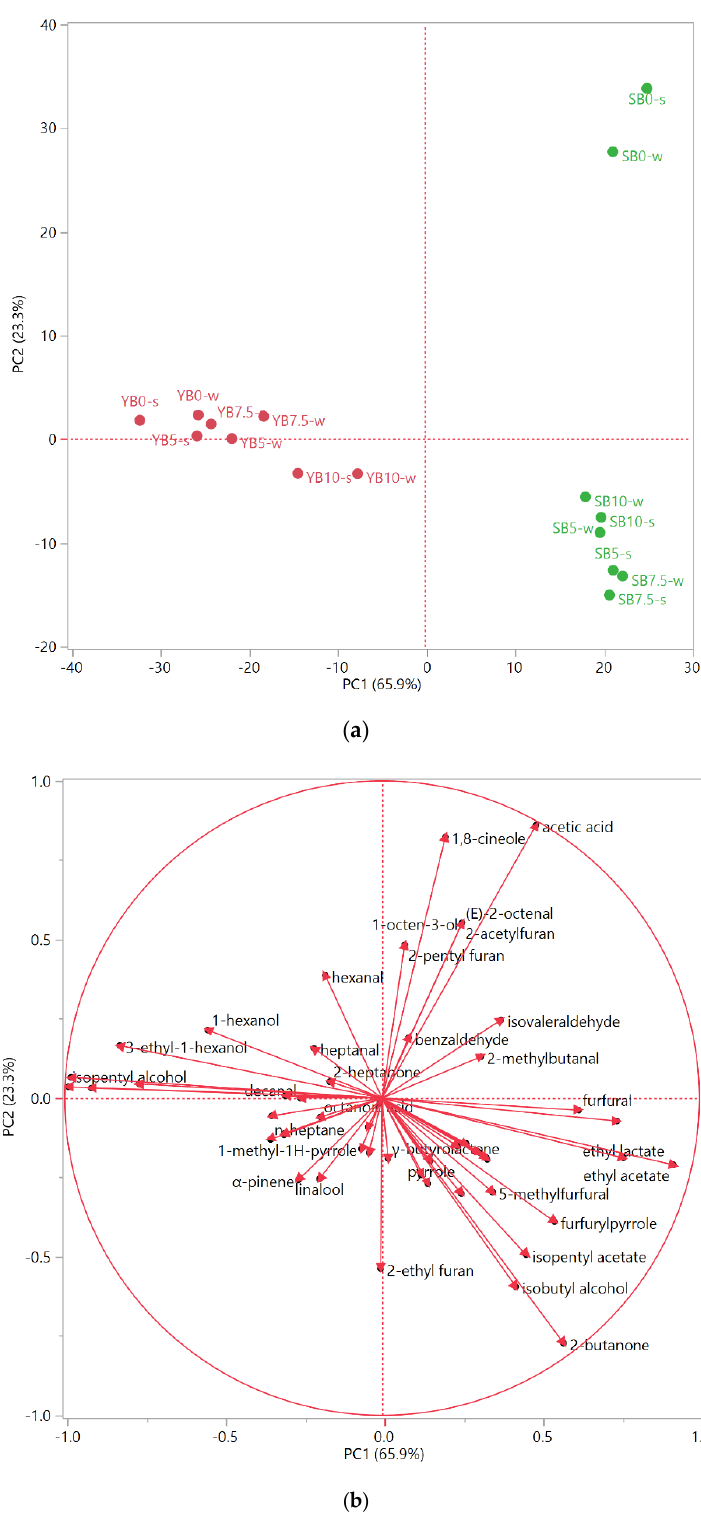
Figure 4. ( a ) Score of the principal component analysis of volatile compounds of breads, ( b ) Loading plots of the principal component analysis of volatile compounds of breads (w = whole or s = sliced). In the case of brewer’s yeast samples, those having the highest content of flaxseed cake (10%) have both PC1 and PC2 negative loadings, while the addition of lesser amounts of flaxseed cake,